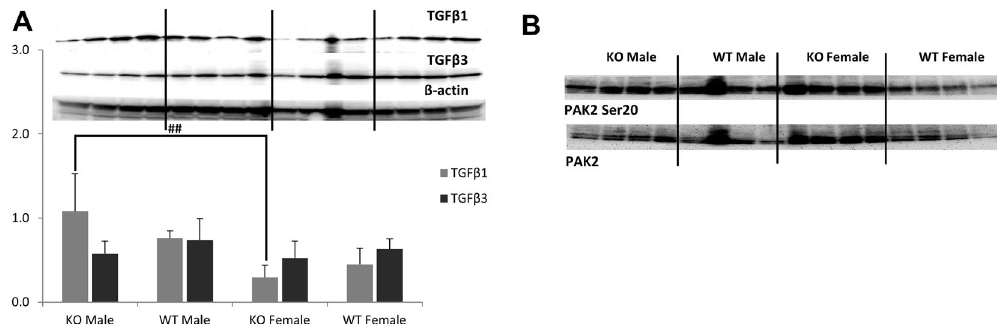
Figure 5. Western blot analysis of TGF β signaling-associated proteins. ( A ) TGF β 1 was significantly higher in Ppif − / − males as compared to females, while no change in TGF β 3 expression was noted among the groups. ( B ) No change in the activation of PAK2 (as pPAK2 Ser20) was observed. Data is presented as average ± SD (n = 4). One-way ANOVA significances were as follows: ( A ) P = 0.004 and P = 0.469 for TGF β 1 and TGF β 3, respectively, and ( B ) P = 0.164 for pPAK Ser20/PAK2, respectively. Significance levels are: ## p < 0.01 for male versus female in WT and Ppif − / −